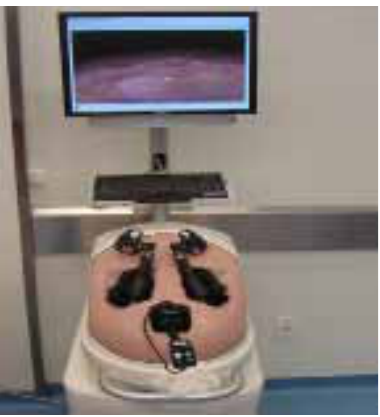
Figure 1 - The virtual simulator -Immersion Lap vR, san Jose, CA.